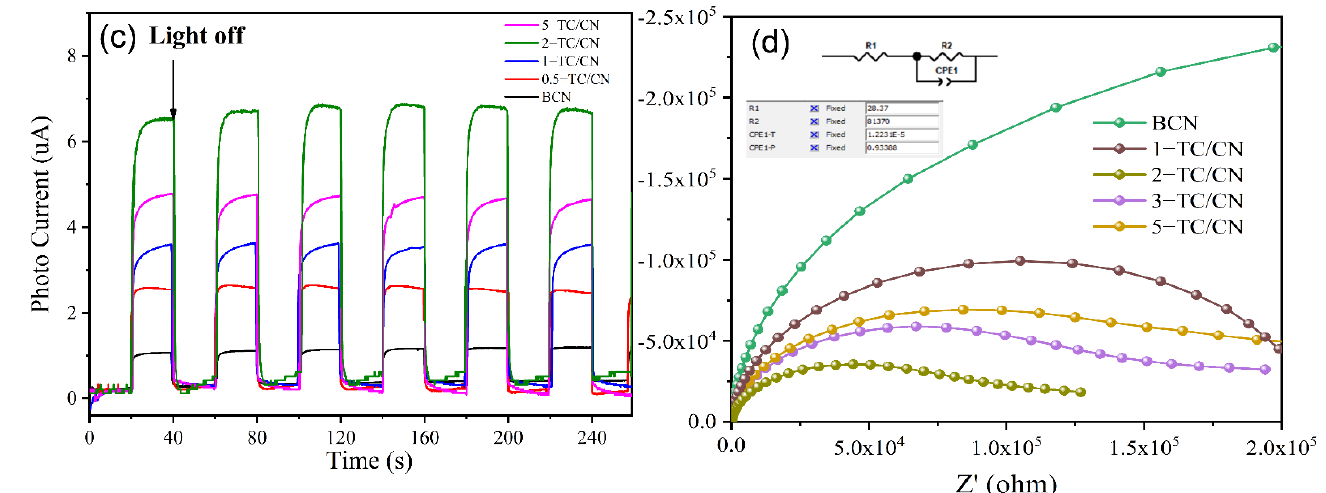
Figure 6. ( a ) Room − temperature PL spectra, ( b ) transient fluorescence − emission spectra, ( c ) transient photocurrent responses, ( d ) EIS spectra, of as − prepared samples.